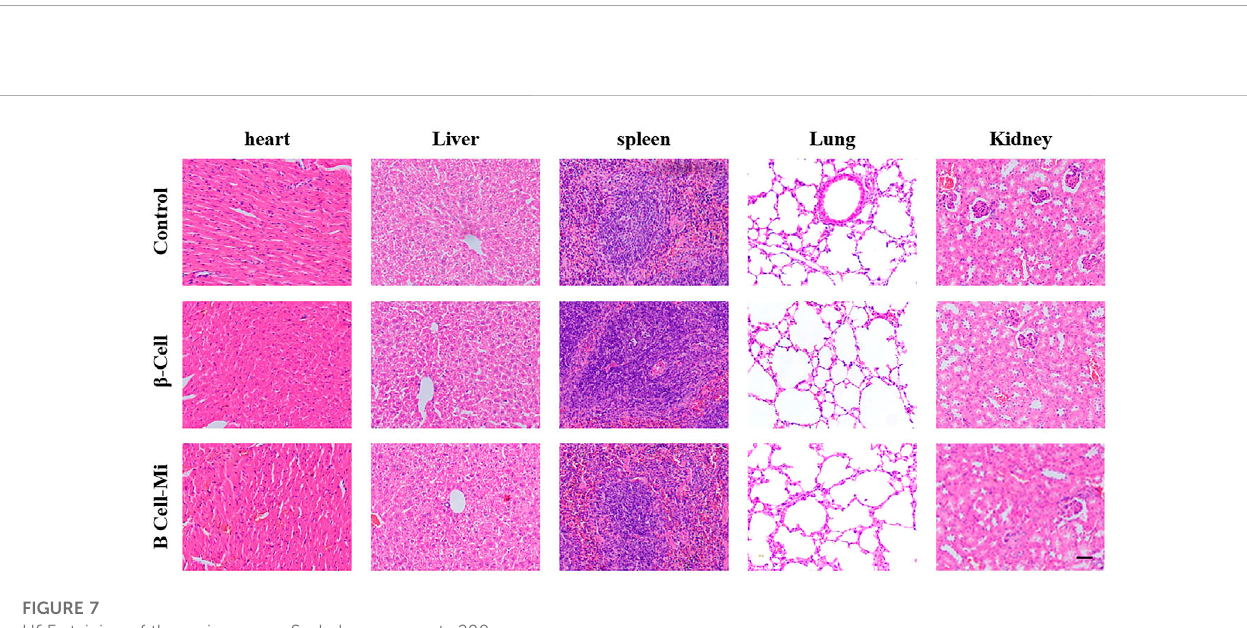
H&E staining of the main organs. Scale bar represents 200 μ